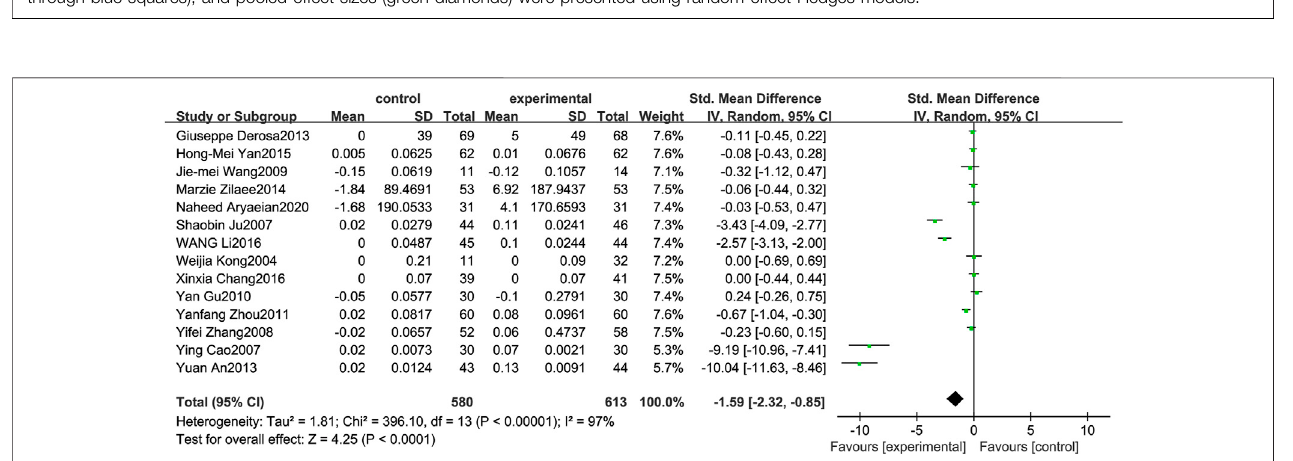
FIGURE5| Meta-analysisandmigrationanalysisoftheeffectofberberineonlow-densitylipoprotein.Forestplotillustratesthedifferencesinchangesinlow-density lipoprotein in adults with metabolic disease who did or did not receive berberine in 14 trials ( n (cid:1) 1,233). The mean difference (blue squares), 95% CI (horizontal lines through blue squares), and pooled-effect sizes (green diamonds) were presented using random-effect Hedges models.